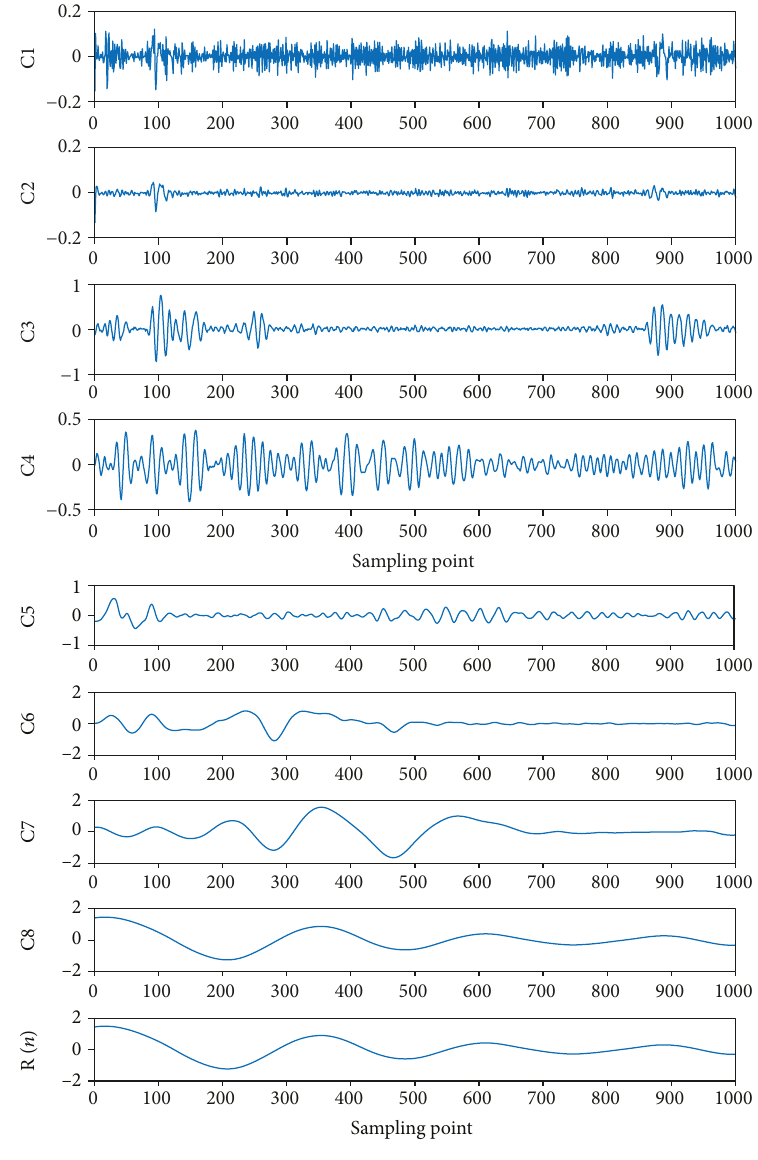
Figure 5: Sea clutter decomposition based on